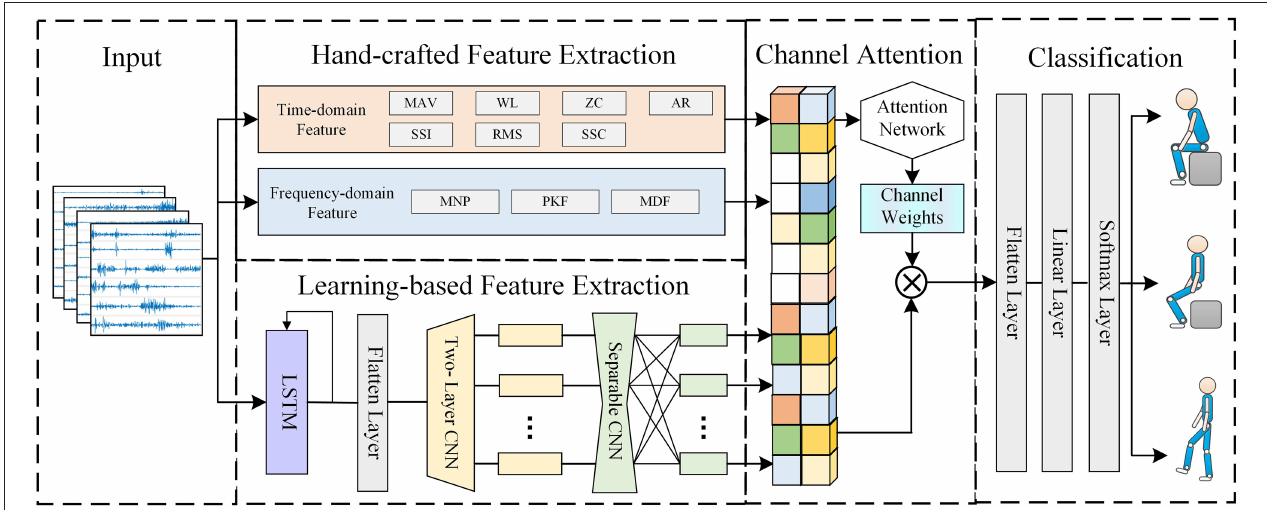
FIGURE 1 | The overall architecture of the HCSNet model. HCSNet is divided into three parts. The first part is data input, and the second part is feature extraction, which uses traditional methods and our previous work MCSNet to extract hand-crafted features and learning-based features respectively, and then uses the attention mechanism to fuse the hand-crafted and learning-based features. The third part is movement